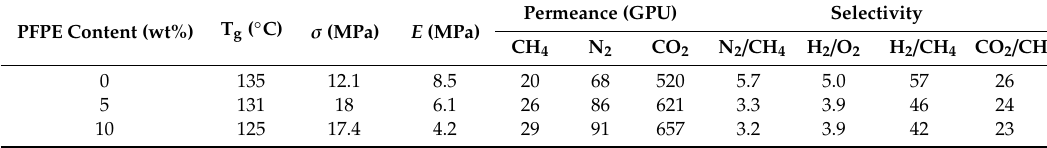
Table 9. Physical and Gas Transport Properties of the Blends of PFMMD and PFPE [34]. PFPE Content